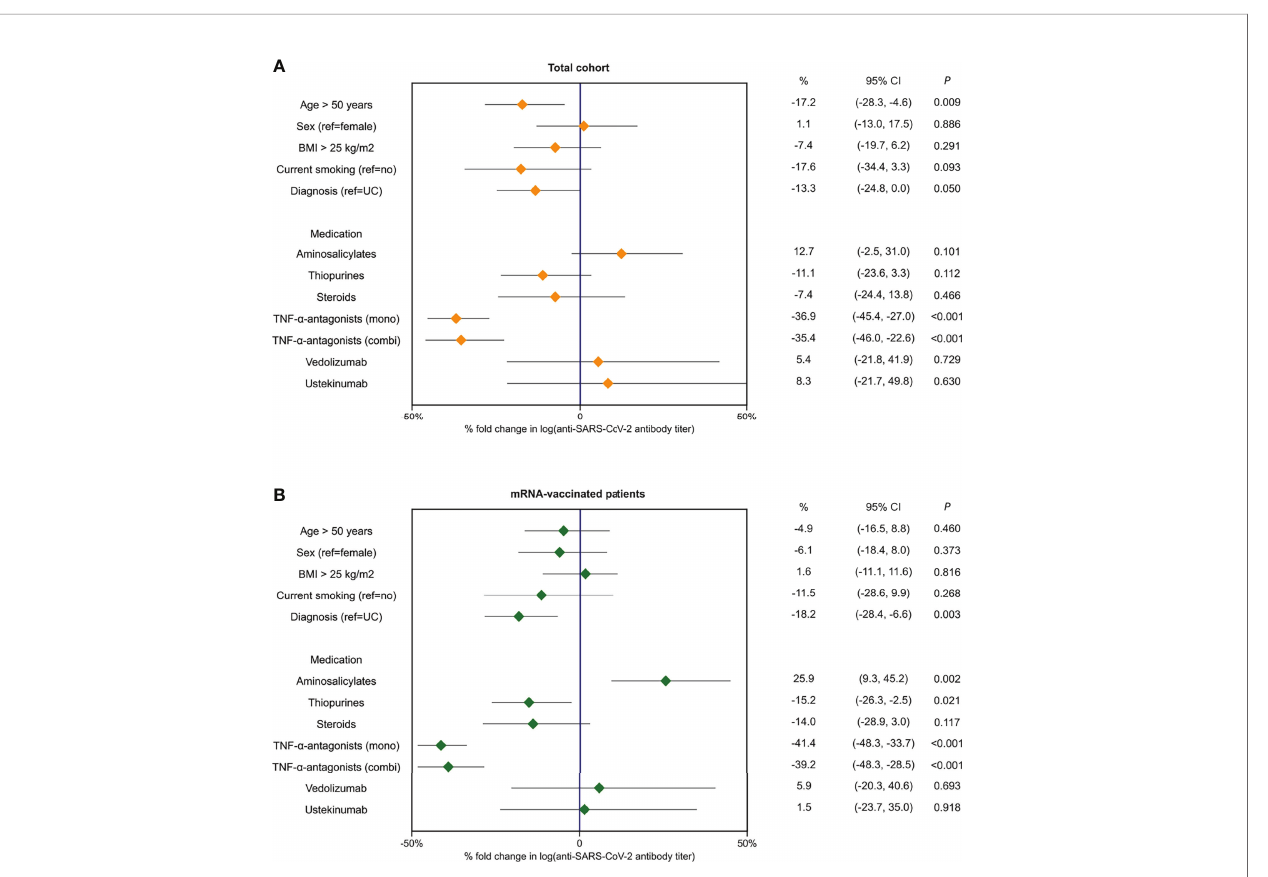
TABLE 3 | Multivariable linear regression analysis showing non-exponentiated beta-coef fi cients for associations between patient characteristics and log-transformed anti-SARS-CoV-2 antibody titers in patients with IBD, for the total cohort and for mRNA vaccines separately. Variable